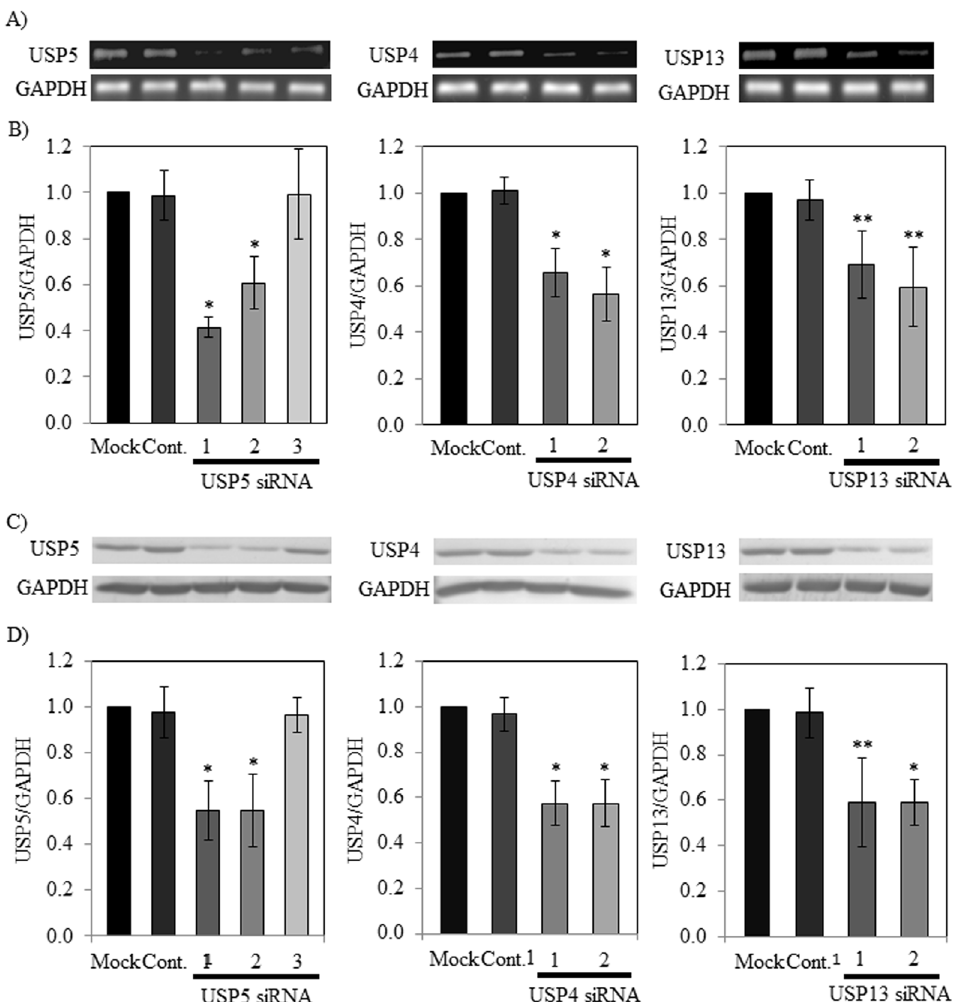
Figure 1. Expression of DUB mRNAs and protein level of DUBs in DUB siRNA knockdown cells. (A) Expression of USP4, USP5, and USP13 mRNAs in RBL-2H3 cells treated with each DUB siRNA was analyzed by real-time RT-PCR. PCR products were detected with agarose gel electrophoresis. (B) Band intensities of PCR products were measured and compared relative to GAPDH. The GAPDH expression pattern in RBL-2H3 cells was used as an internal control. (C) Protein level of USP4, USP5, and USP13 in RBL-2H3 cells treated with each DUB siRNA was analyzed by western blotting. (D) Intensities of detected bands were measured and compared relative to GAPDH. The GAPDH level pattern in RBL-2H3 cells was used as an internal control. Each value represents mean 6 standard deviation of triplicate determinations. The significance of differences from each control value was calculated using the Student’s t-test (*p , 0.05, **p , 0.1).